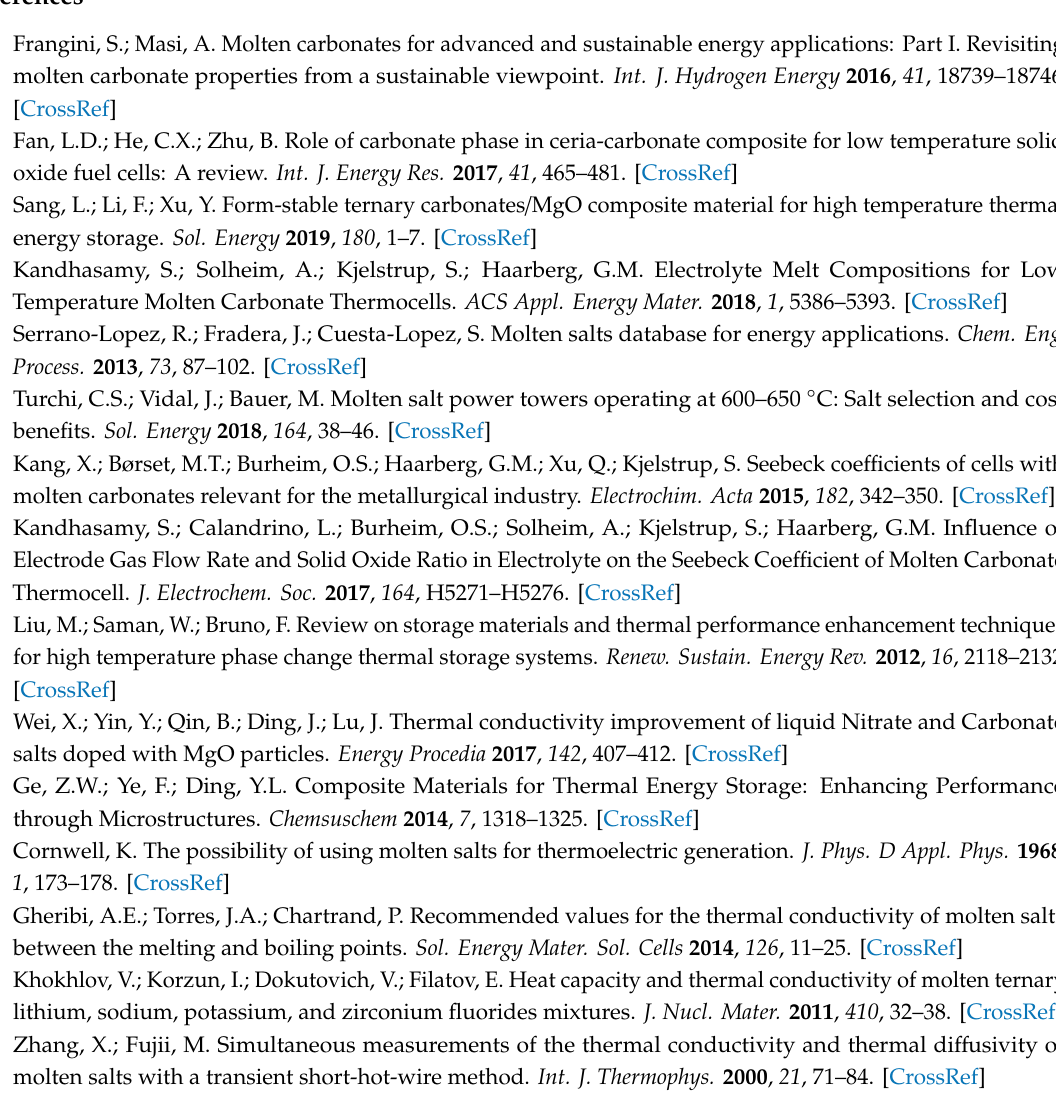
Figure S3: DSC measurement to determine the Cp of LNC-MO; Figure S4 and S5: Recorded DSC heat flow and TGA weight loss profiles of LNC-AO, LNC-CO, LNC-LAO and LNC samples (30 mg of sample); Table S1: DSC temperature program used in determining the